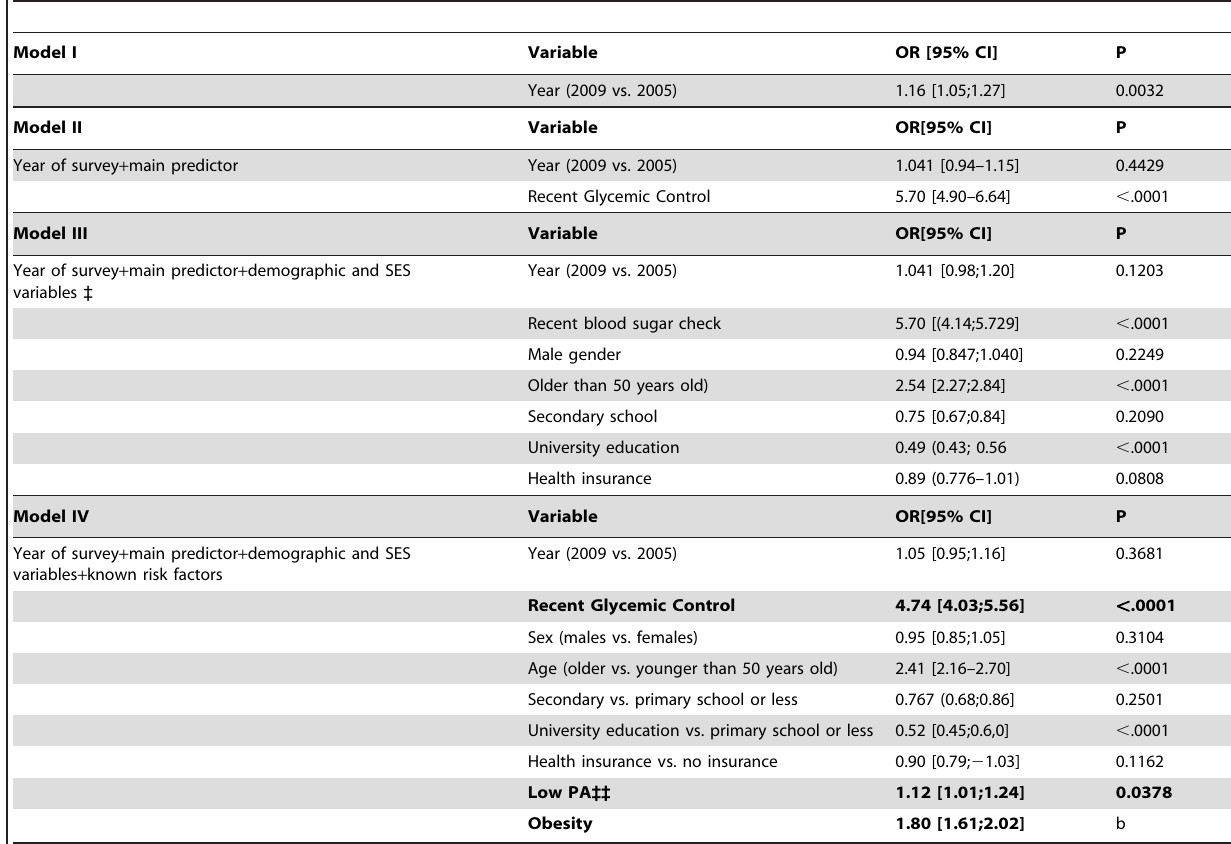
Table 3. Four-step logistic regression models predicting self-reported